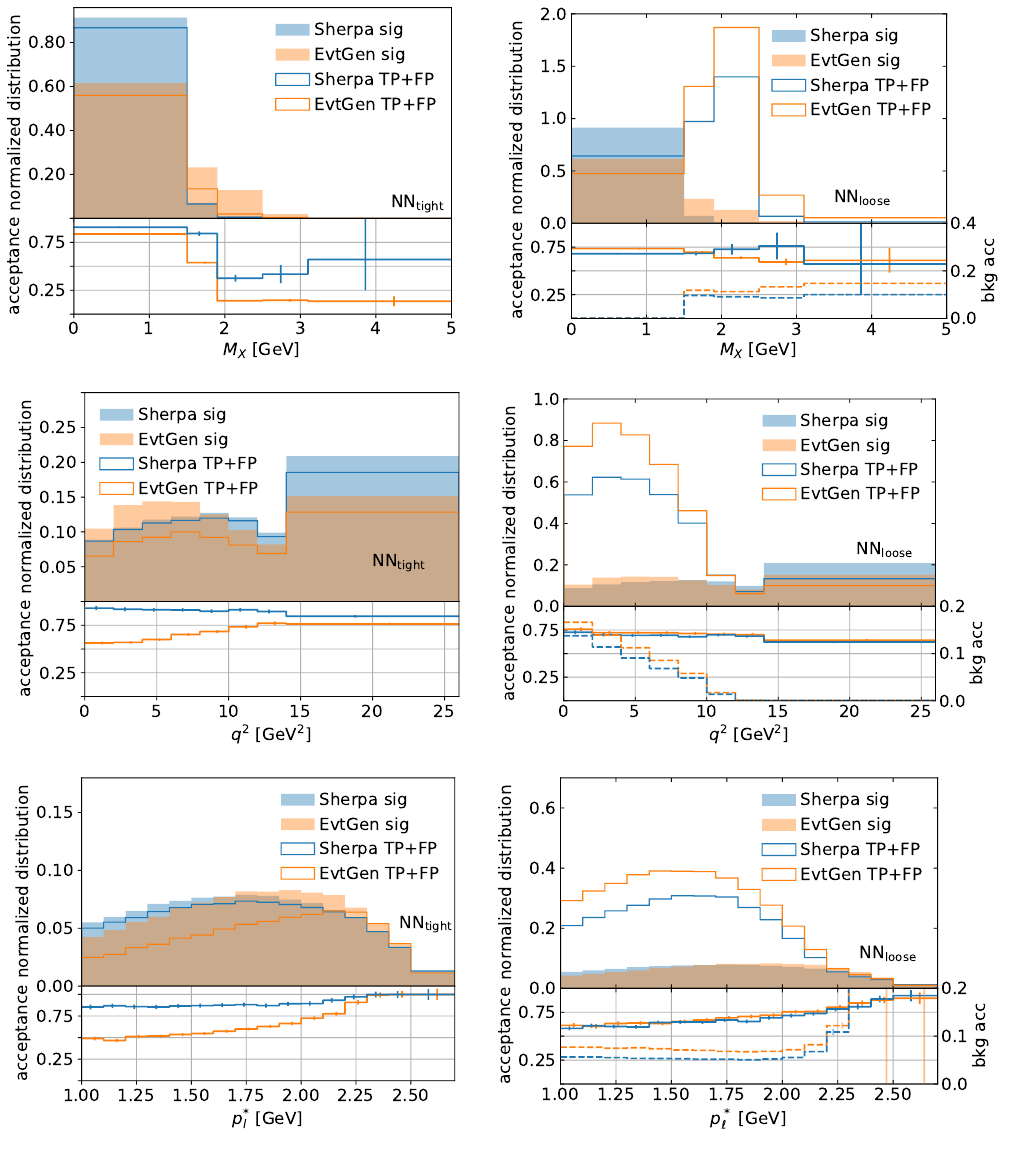
Figure 14 . As in figure 6, but using S HERPA instead of E VT G EN data for training the BNNs.